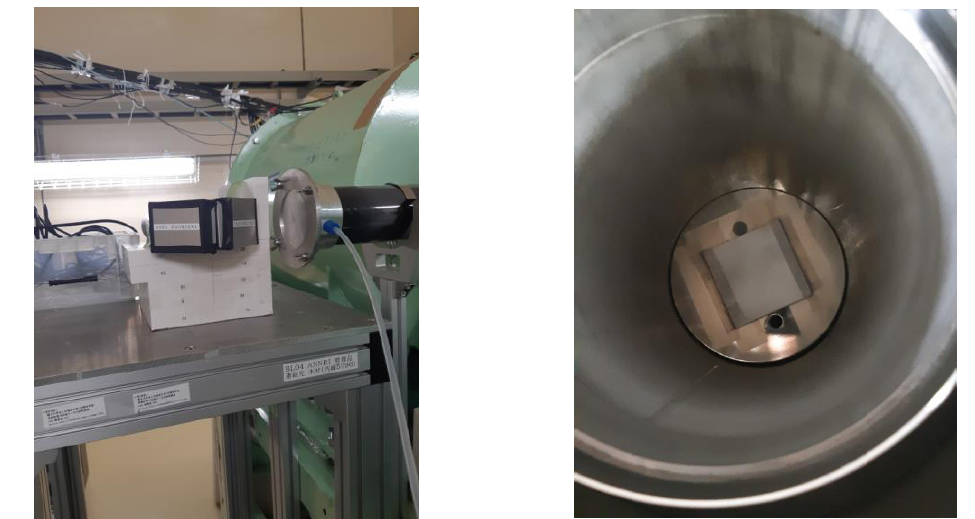
Figure 3. Li-glass detectors (left) and 5 mm thick Mo sample (right) installed on